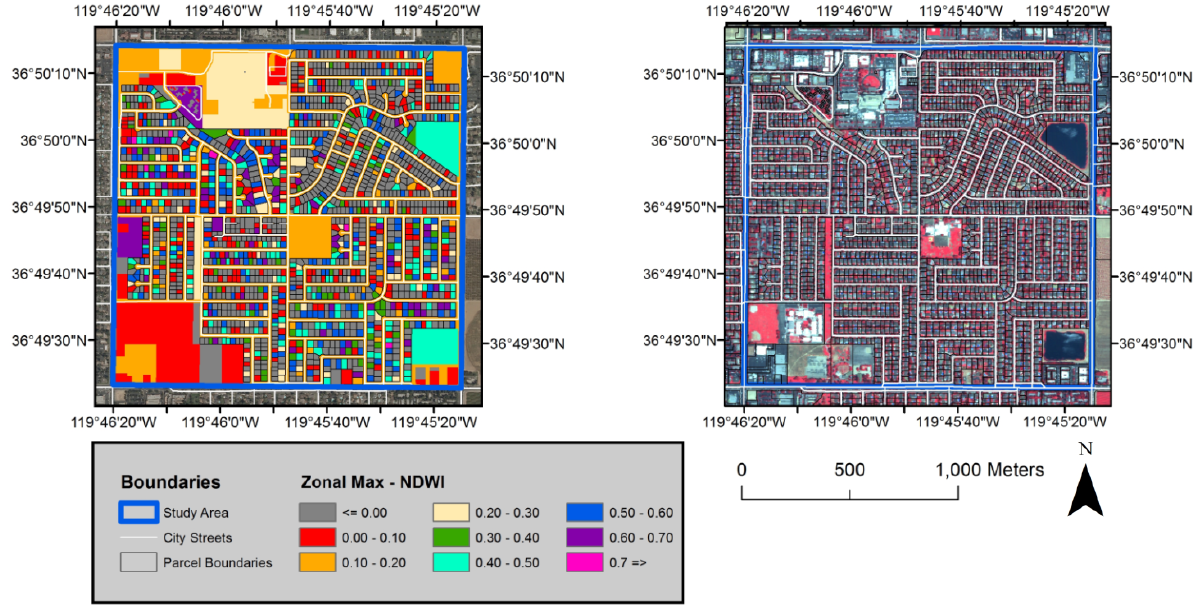
Figure 5. Color-coded Zonal Max NDWI image of residential neighborhood ( left ). QuickBird image (copyright 2013) showing the near infrared (NIR), red, and green false color composite of the study area ( right ). Parcels with asphalt and vegetated surfaces, and which do not have water surfaces, have low values of NDWI assigned to them, while parcels with water surfaces have higher values assigned to